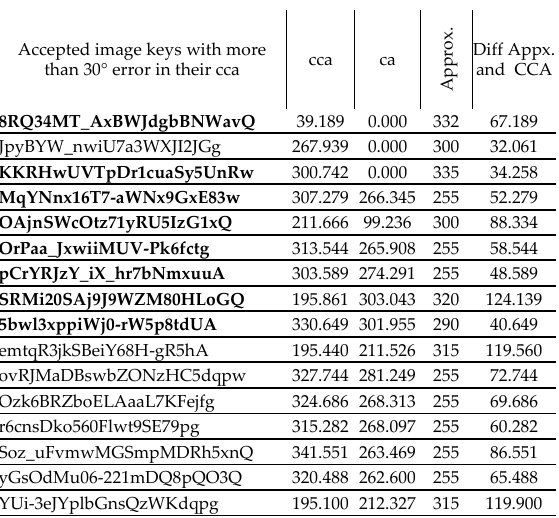
Table 2. Image keys revealed with more than 30° angle